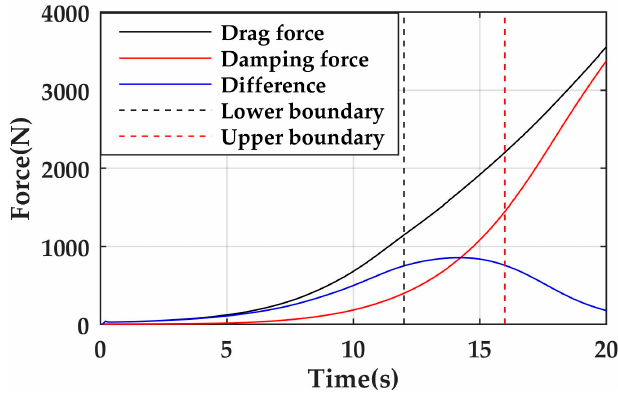
Figure A4. Difference force in group 2.